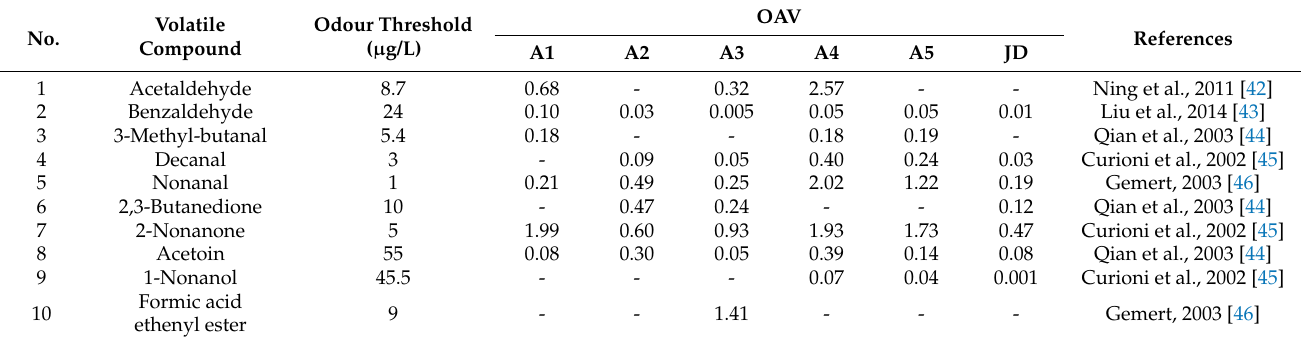
Table 4. Odour activity values (OAVs) of the volatile flavour compounds produced in yogurts following fermentation with different ratios of L. delbrueckii subsp. bulgaricus IMAU20312 and S. thermophilus IMAU80809 in starter cultures compared with the commercial starter